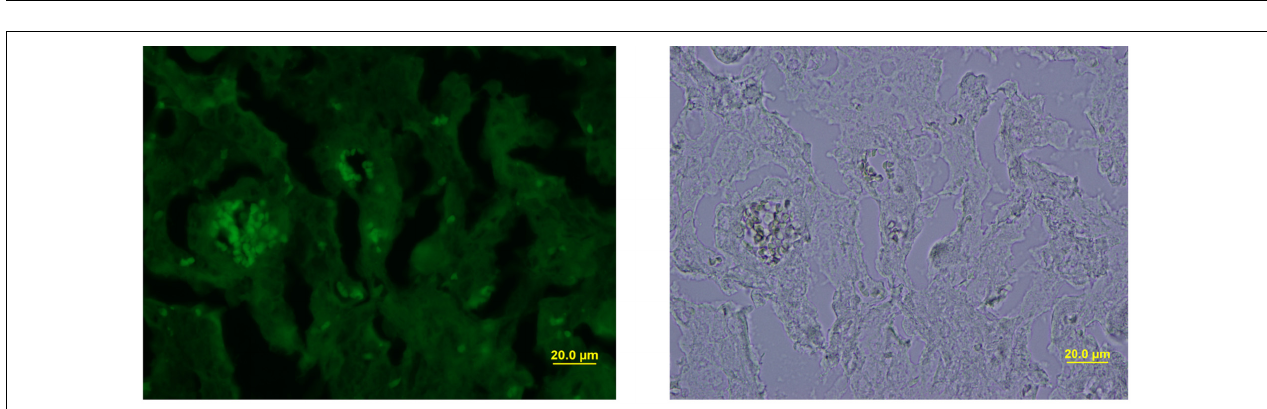
FIGURE 5 | Fluorescence microscopy and bright-field staining of maternal liver infected with S. aureus SH1000 (pSGFPS1).